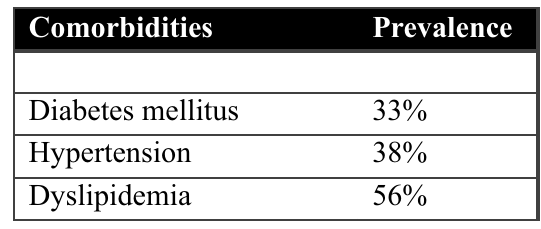
Table 01. Prevalence of vascular risk factors among the study sample.